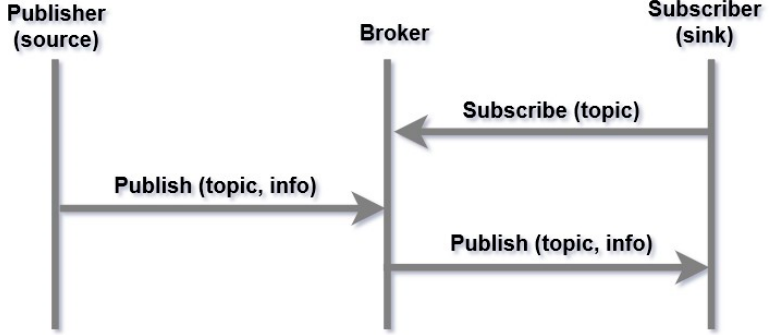
Figure 4. Messages exchanged by MQTT protocol.